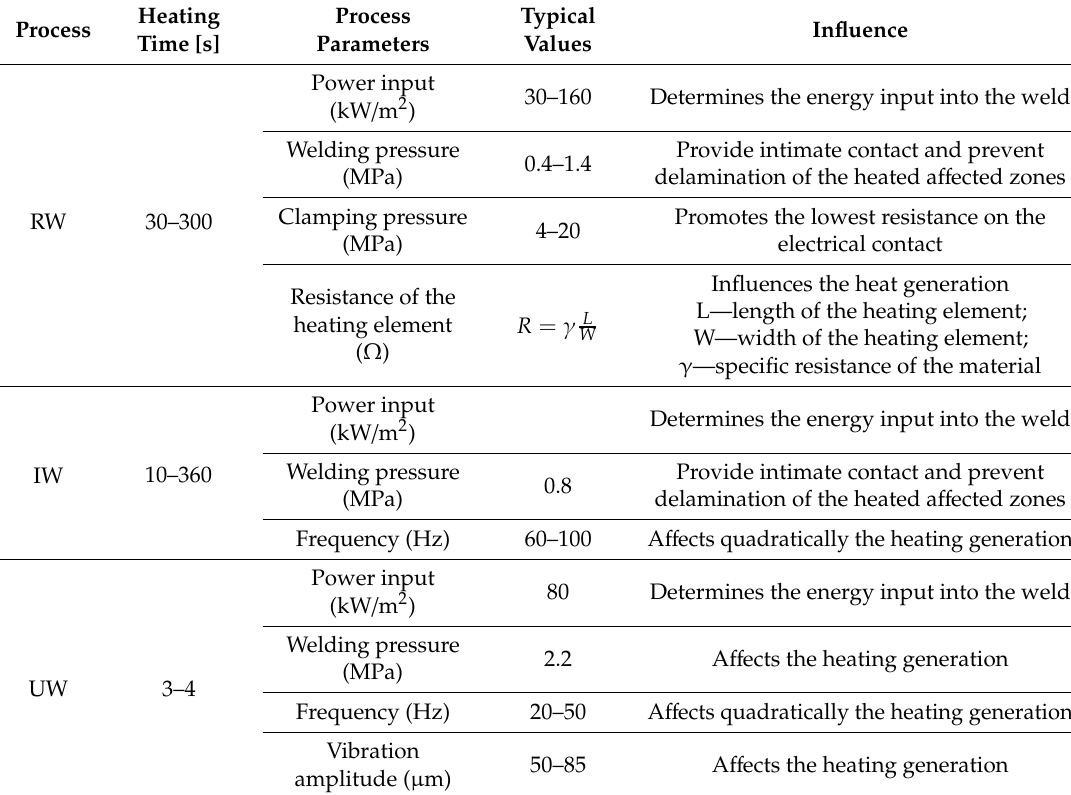
Table 2. Process parameters and its typical values of resistance welding (RW), induction welding (IW), and ultrasonic welding